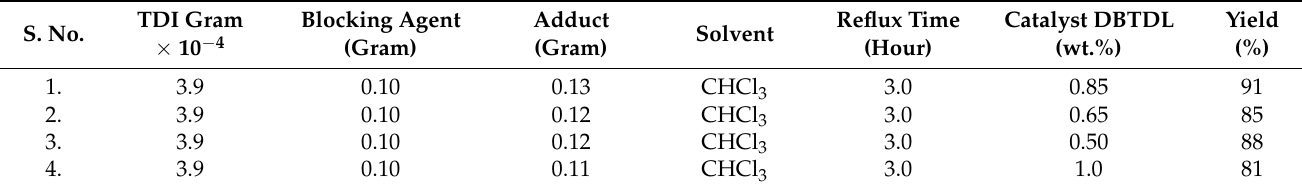
Table 1. Synthesis of 4-(3-bromophenyl)-1H-pyrazole-blocked TDI adduct.